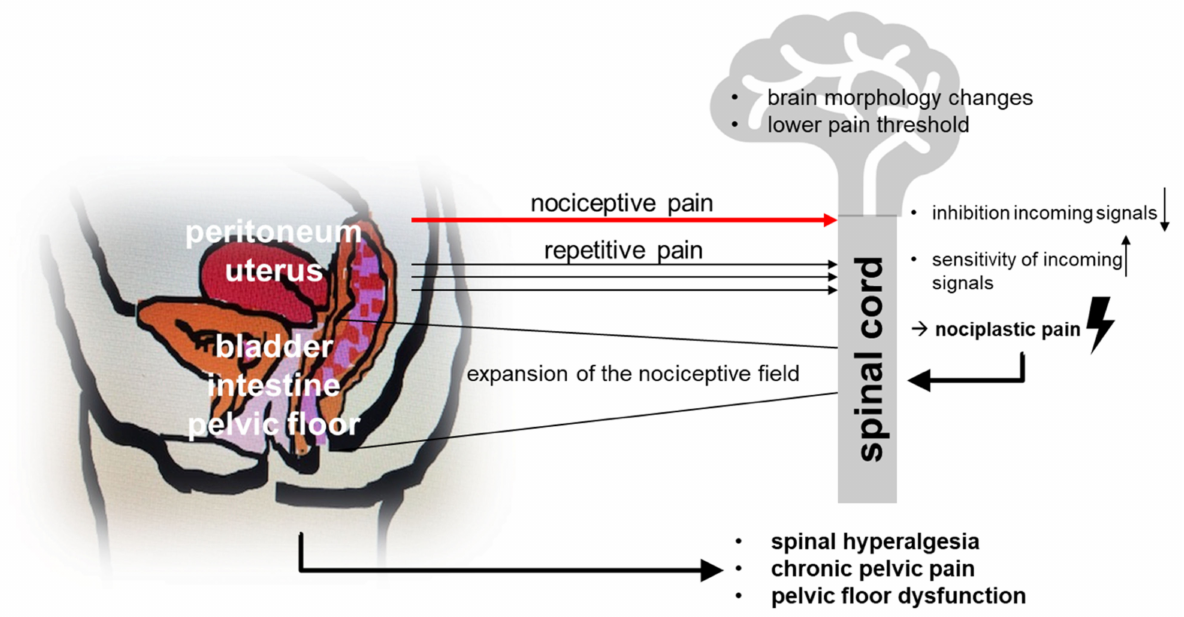
Figure 1. Pathophysiology of chronic pain disorders in women with